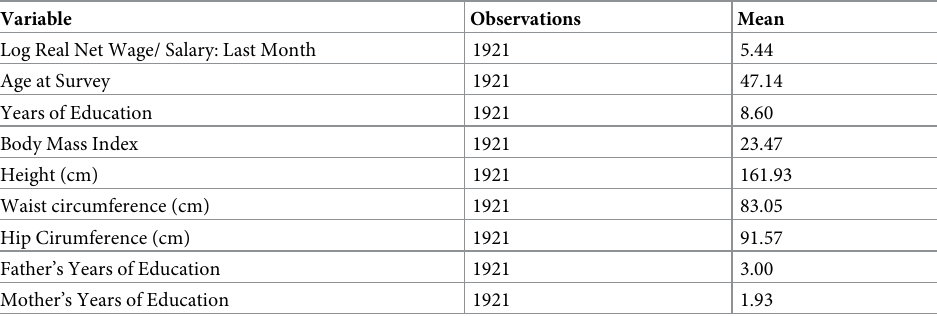
Table 1. Summary statistics.